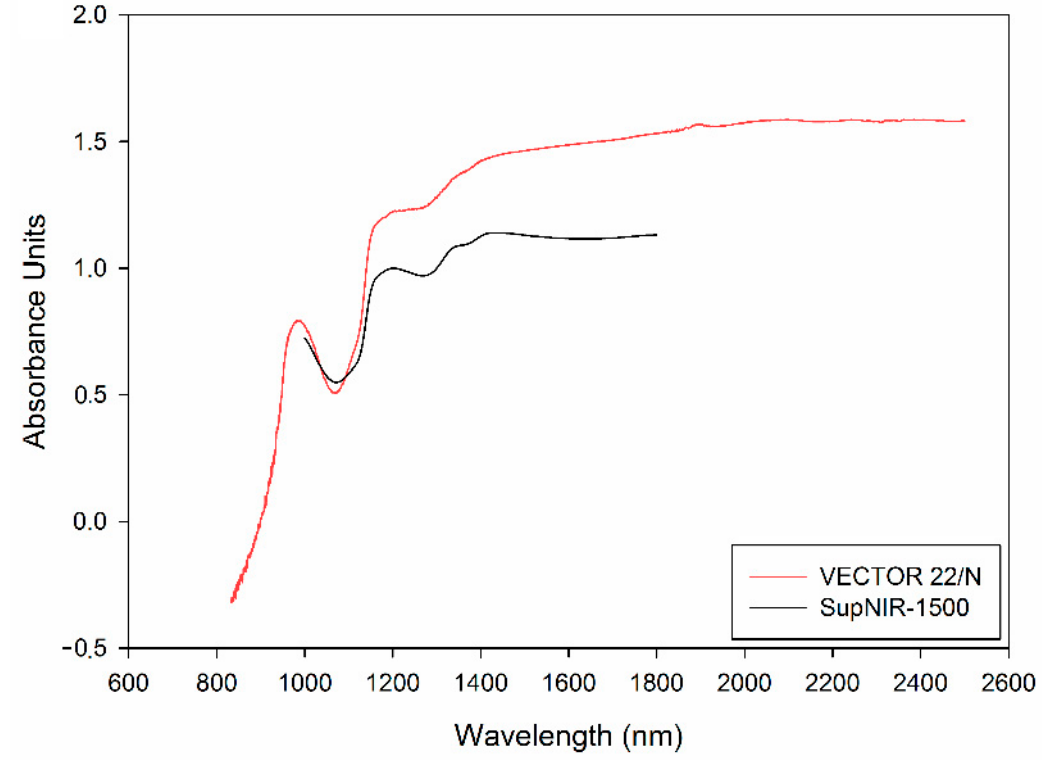
Figure 3. The average spectra conducted mean normalization of Ruby Seedless.